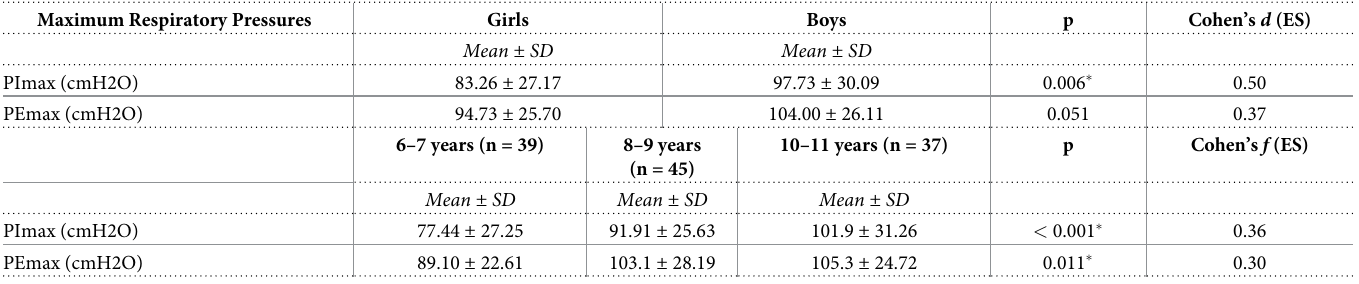
Table 2. Differences in maximum respiratory pressures stratified by sexes and age